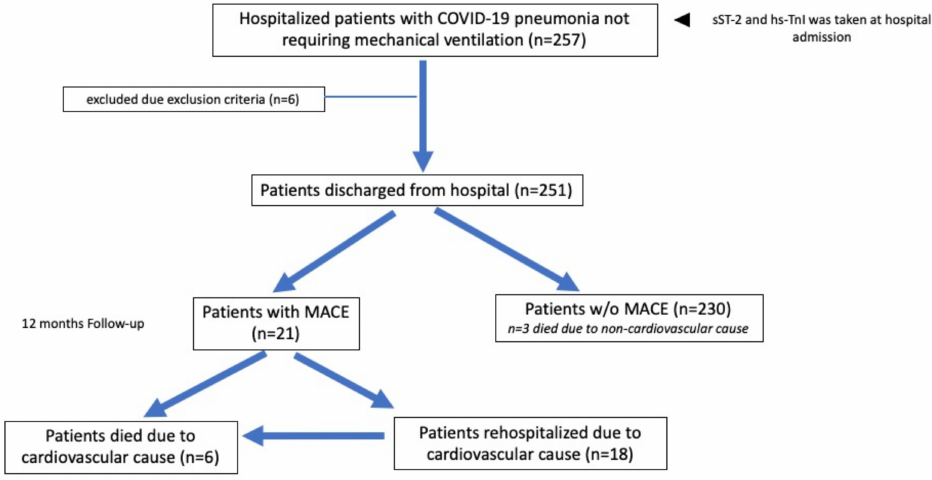
Figure 1. Design of the